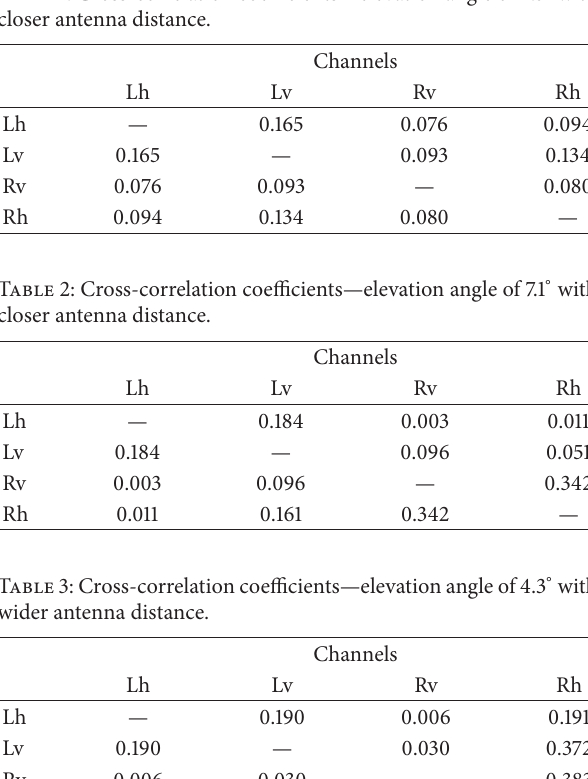
Table 1: Cross-correlation coefficients—elevation angle of 4.3 ∘ with closer antenna distance.